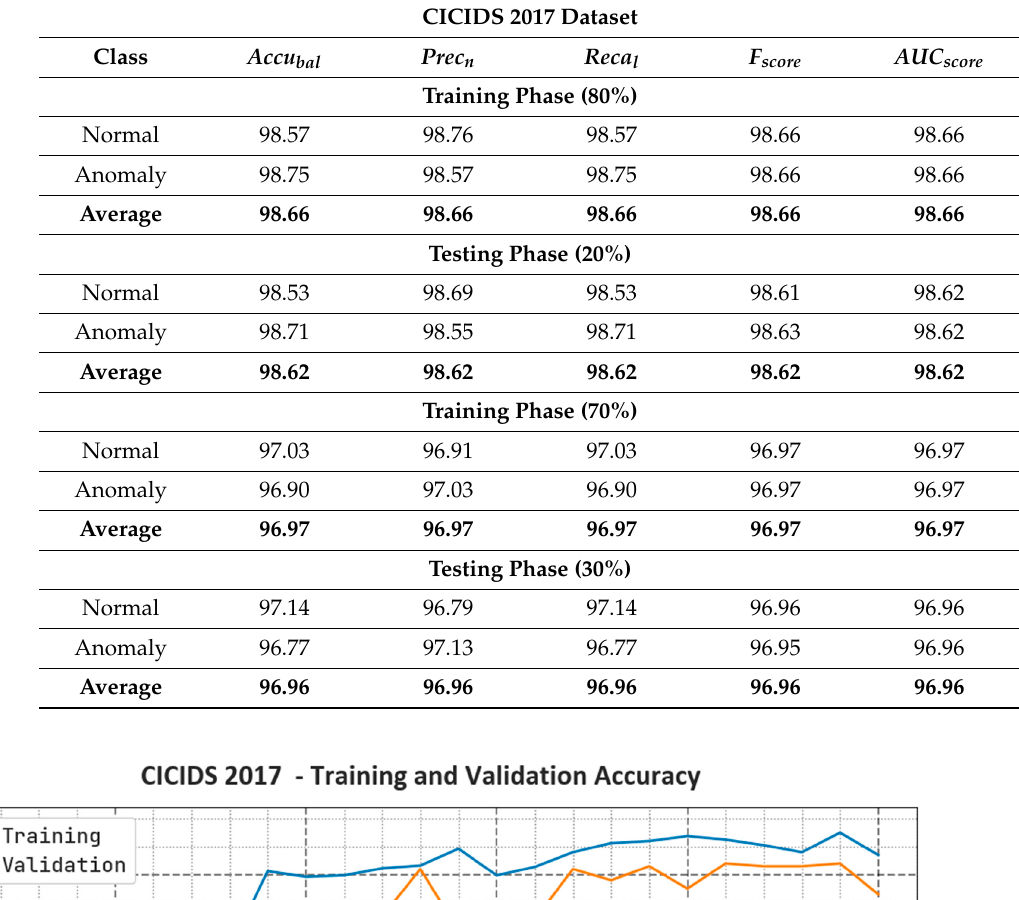
Table 3. Intrusion recognition outcome of XAIID-SCPS system on the CICIDS 2017 dataset.